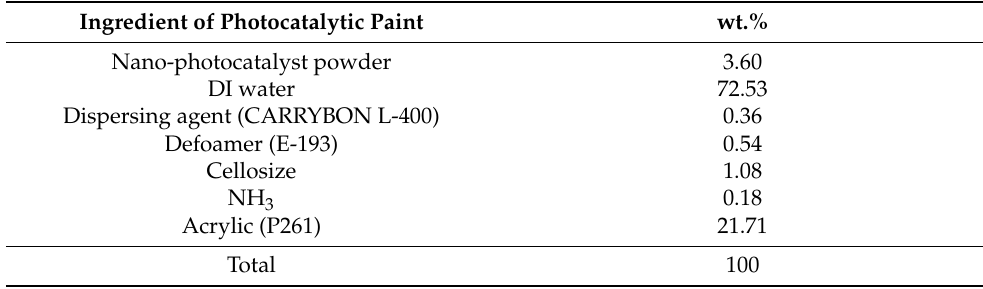
Table 1. Formulation of the photocatalytic paint. Ingredient of Photocatalytic